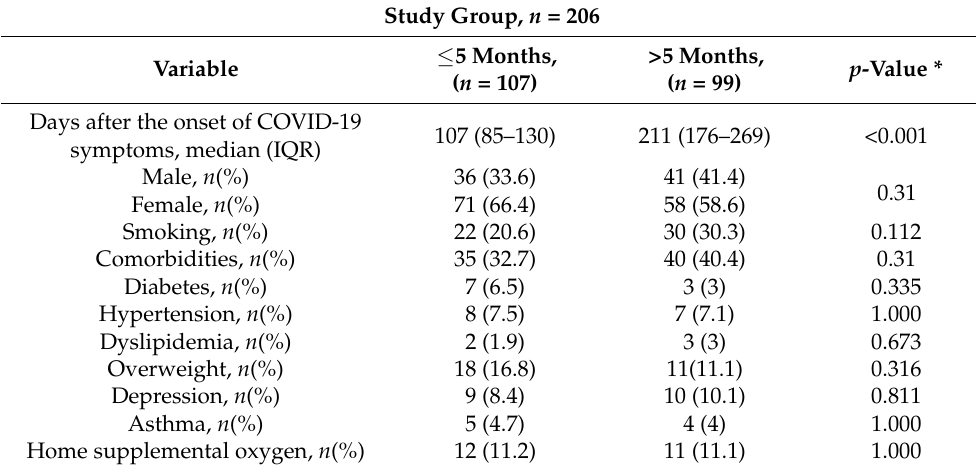
Table 3. Comparison of general characteristics and comorbidities between